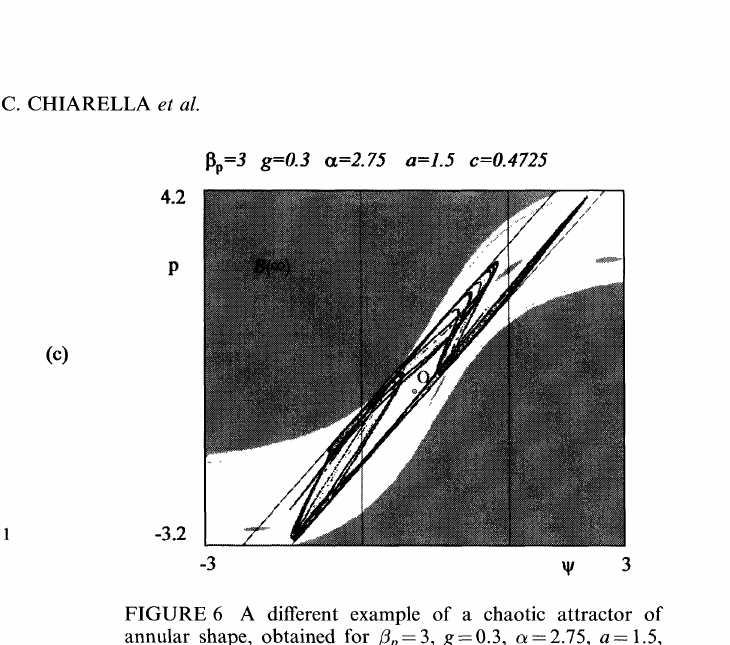
FIGURE 6 A different example of a chaotic attractor of annular shape, obtained for /3p= 3, g--0.3, =2.75, a= 1.5, c=0.4725: the basin of the attractor is the white area, while the grey points have divergent trajectories. The presence of only few "holes" is due to the fact that arcs on the boundary of B() have "just" crossed the critical curve